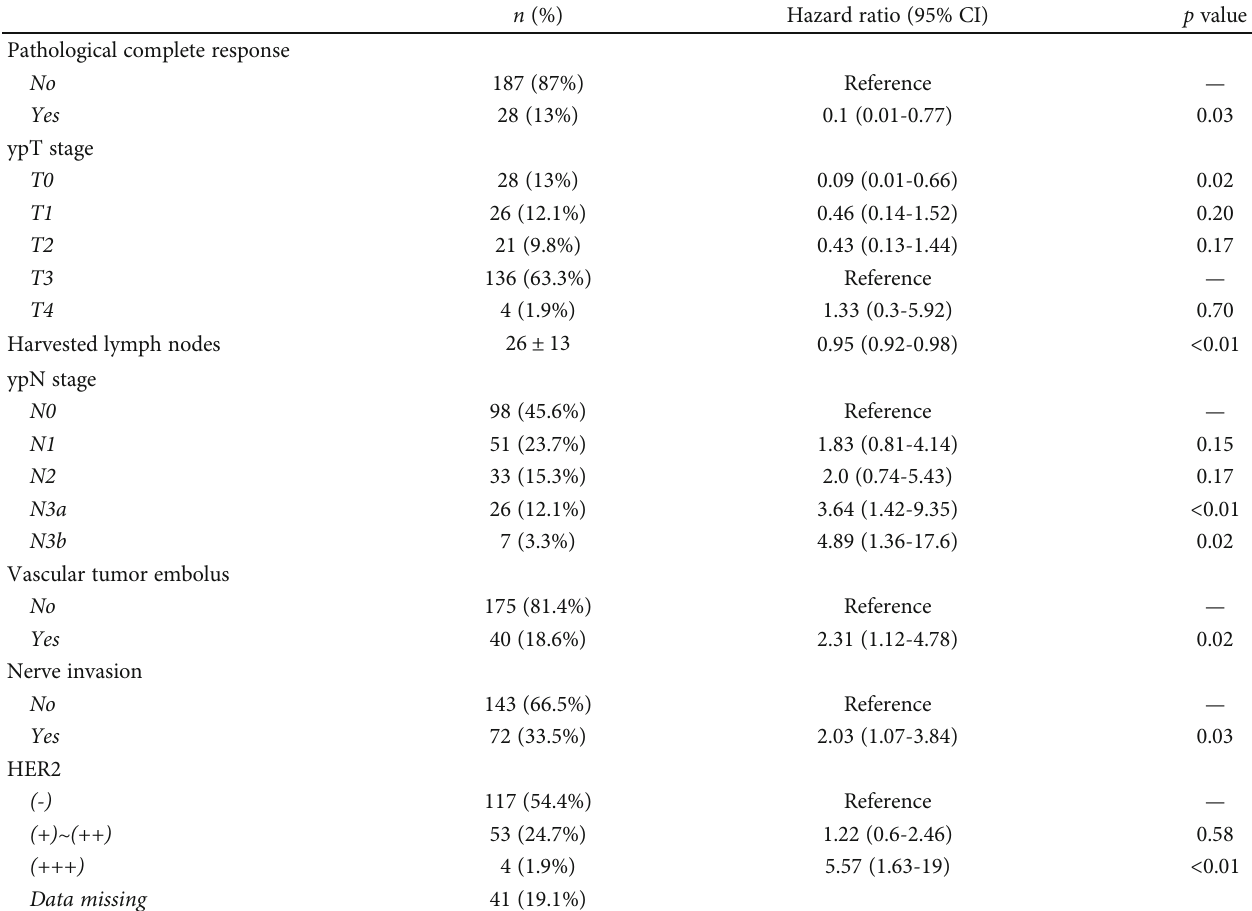
Table 3: Pathological fi ndings, hazard ratios, and p values from univariable survival analysis ( n = 215 ).